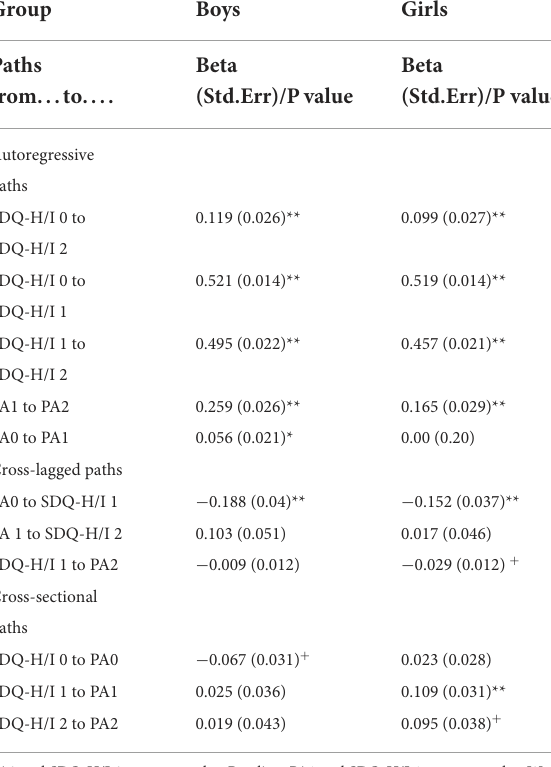
TABLE 6 Significant paths coefficients of Model 3 between PA and SDQ-H/I. Group Boys Girls